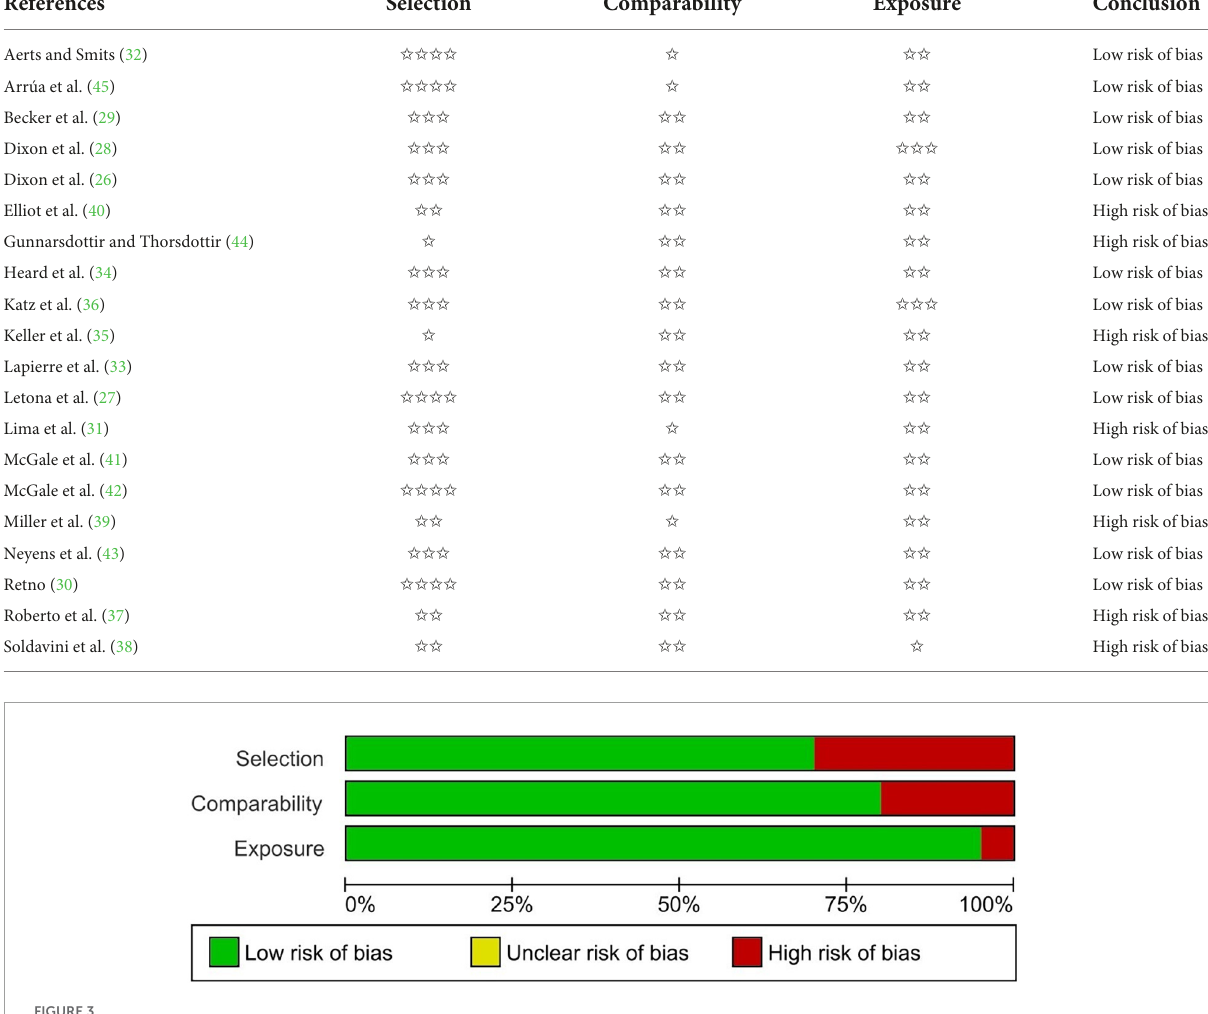
FIGURE3 Risk of bias